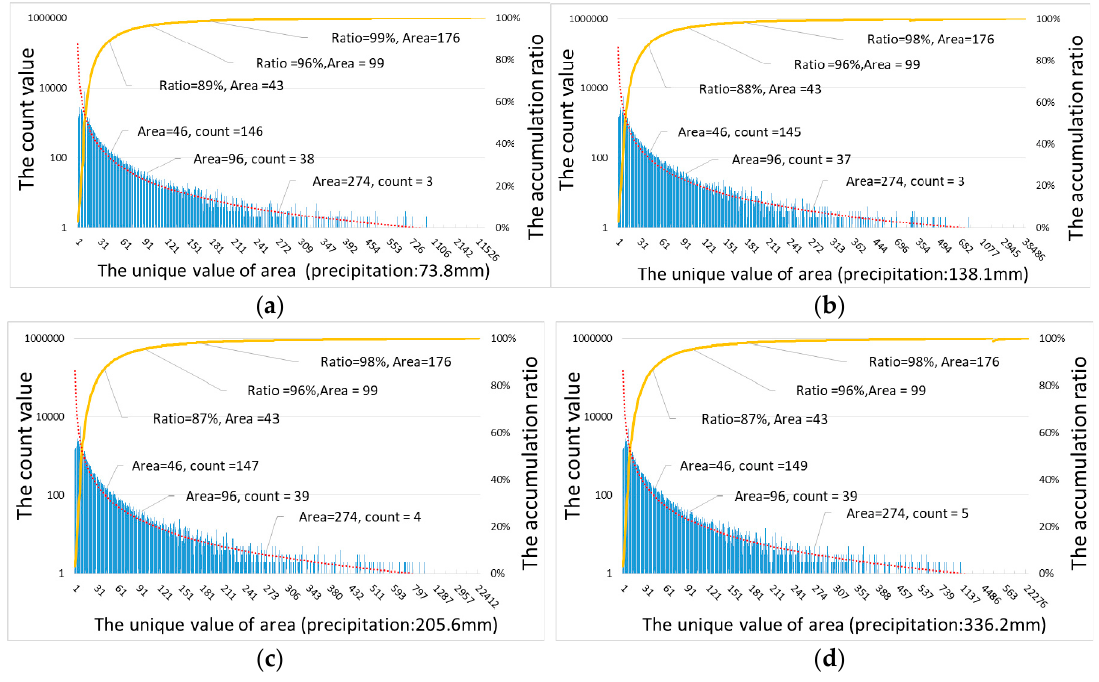
Figure 6. The area frequency distribution of the basic units in the four kinds of precipitation. The precipitation in Figure ( a – d ) is 73.6 mm, 138.1 mm, 205.6 mm, and 336.2 mm, respectively.